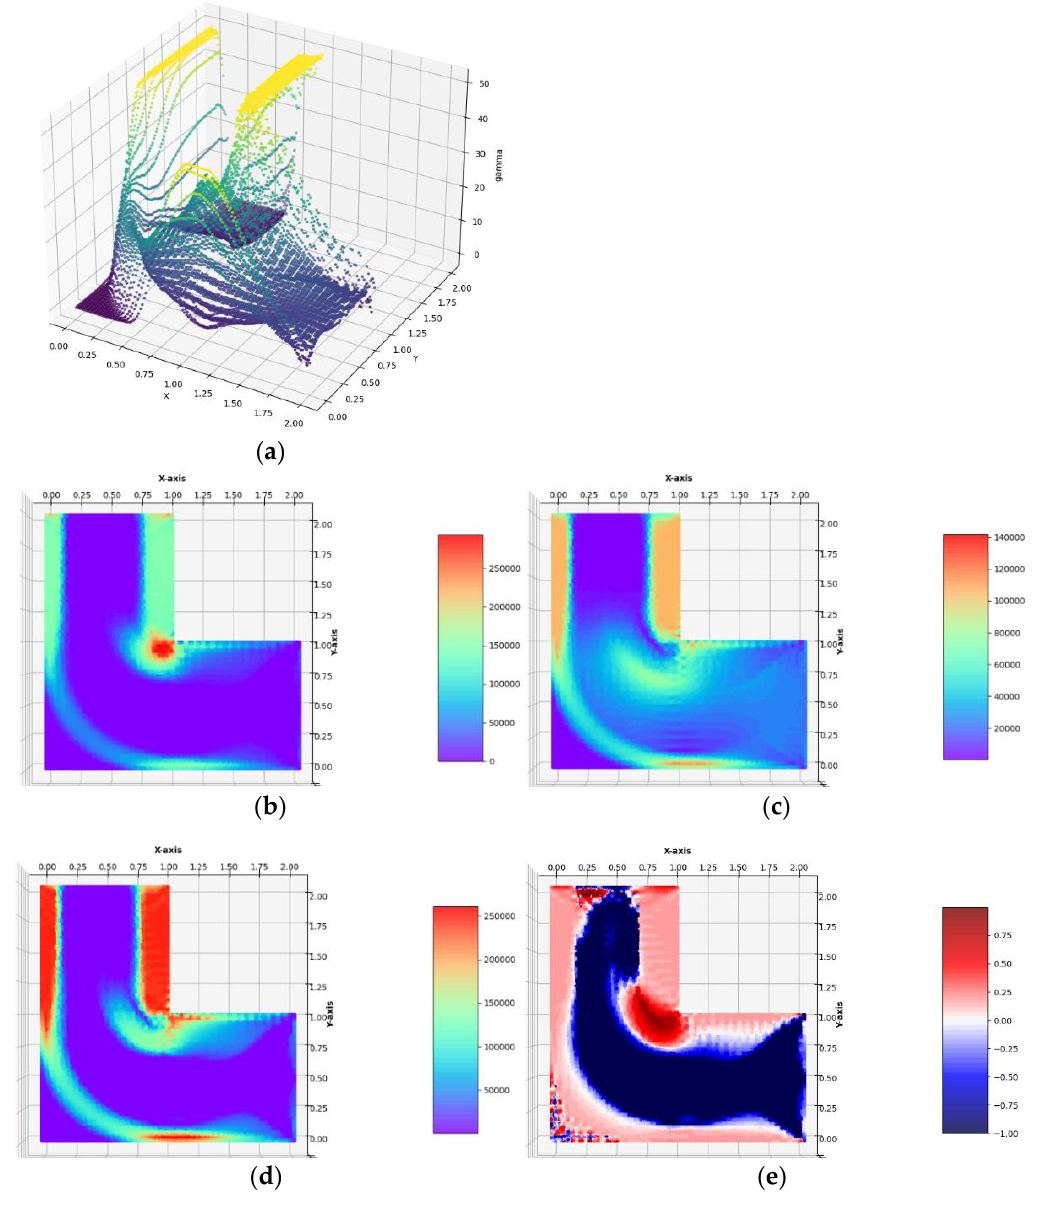
Figure 11. Optimal solutions of the problem of Example 2. ( a ) The plot of the γ function, ( b ) bulk modulus k * / b , ( c ) shear modulus µ * / b , ( d ) Young’s modulus E * / b , ( e ) Poisson’s ratio ν * in the case of FEM mesh composed of quadrilateral elements.